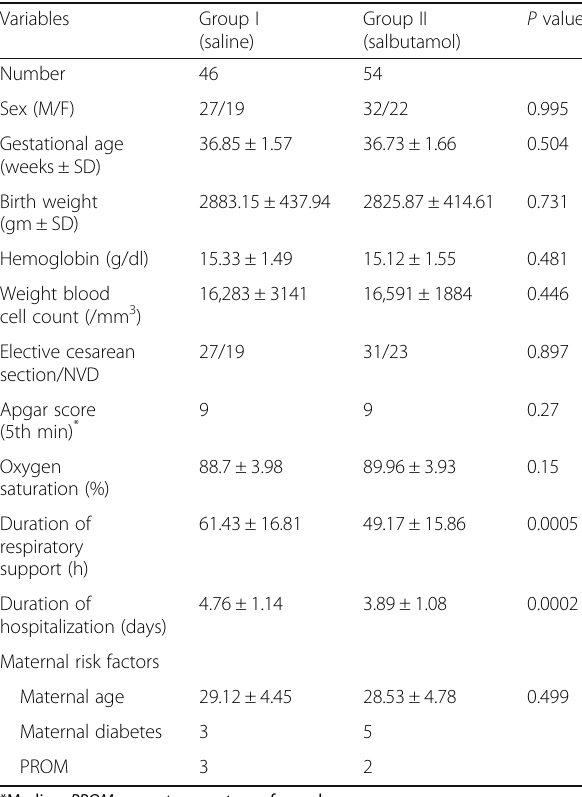
*Median. PROM premature rupture of